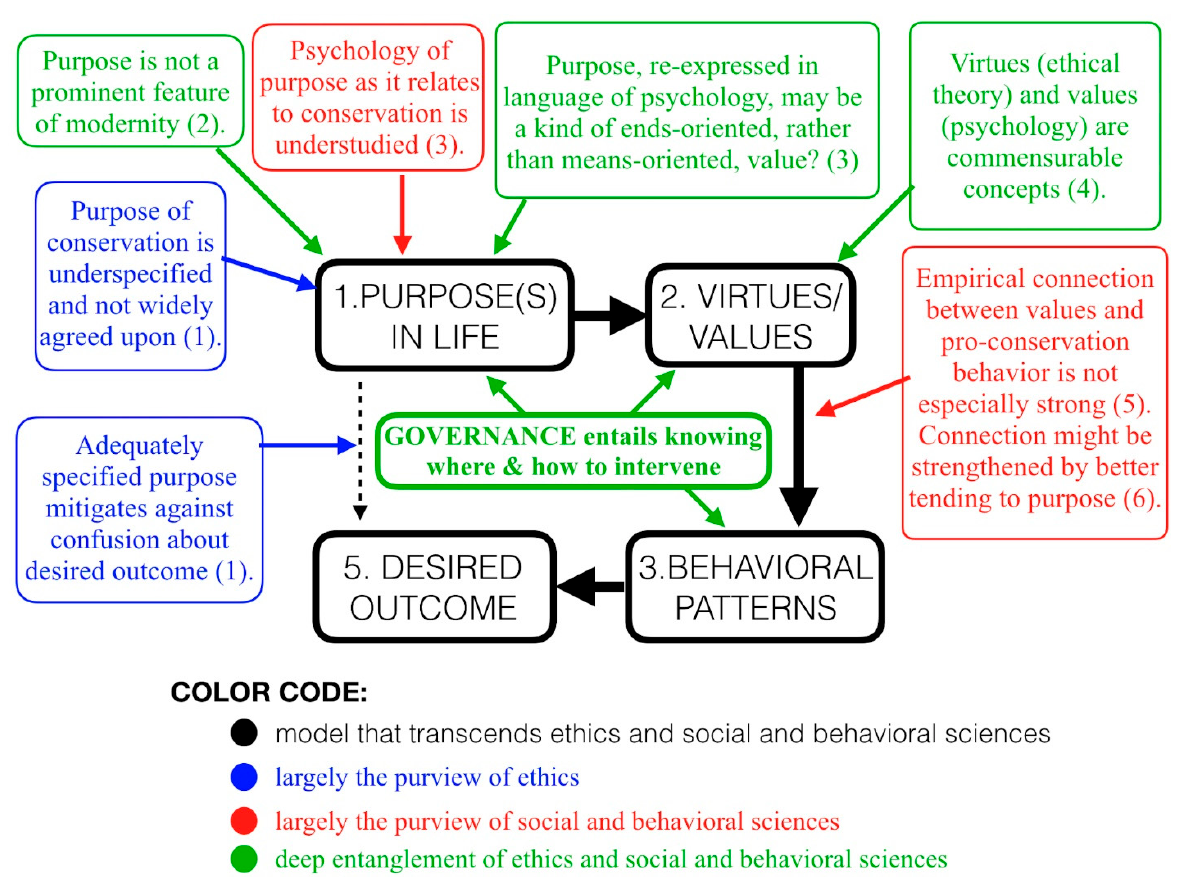
Figure 3. The black portions represent a simple model of behavior that transcends ethics and psychology. This model suppresses some of the intermediary steps depicted in Figure 2 to help draw attention to other more salient elements of the model. The nature of governance is represented from within that model of behavior (green). Colored portions (blue, green, red) from outside the black model imply with useful precision how to appropriately juxtapose the normative and empirical elements of governance as it pertains to conservation. Numbers in parentheses indicate sections of this paper that address the various boxed ideas: (1) Purpose in Conservation, (2) Purpose Lost, Purpose Found, (3) Purpose Is Understudied In Conservation Psychology, (4) Appendix B, (5) Behavioral Science and Values and (6) Figure 2. Values refers to “transcendent values” as that term is used in the main text.